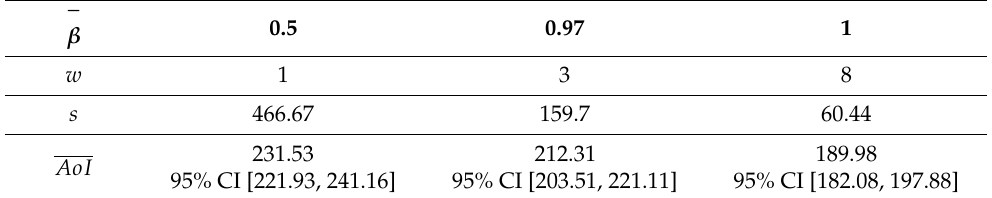
Table 3. w , s , and AoI for λ = 1/180 s − 1 , α = 0.9, AoI α = 420 s , varying β .